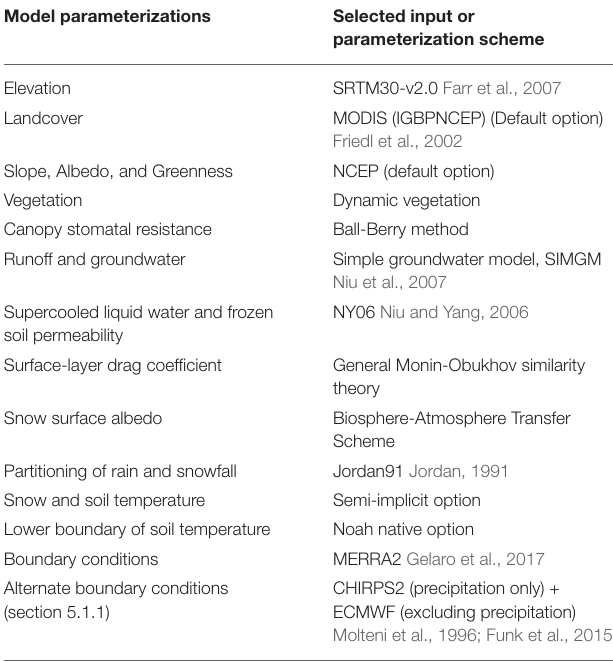
TABLE 1 | Selection of physical parameterizations in LIS for use with Noah-MP.